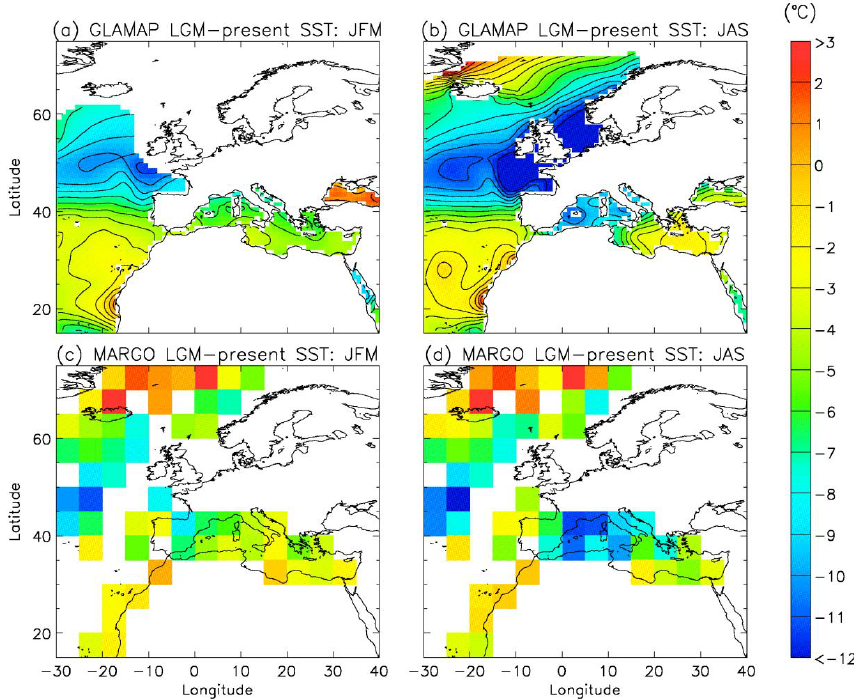
Fig. 5. Difference in climatological SST LGM-present for Paul and Sch¨afer-Neth (2003) (a) winter and (b) summer and for MARGO Project Members (c) winter and (d) summer. For each palaeo-environmental reconstruction, the present day SST climatology is from the World Ocean Atlas of Levitus (2006).